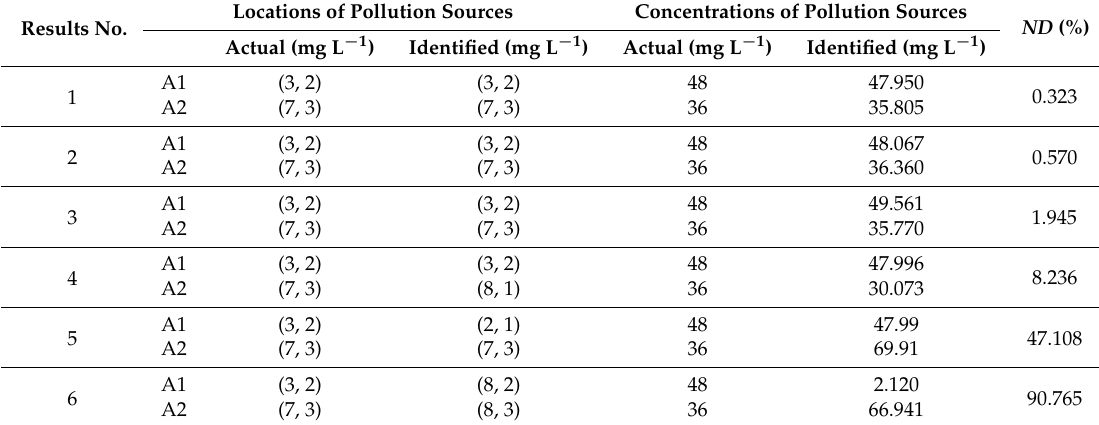
Table 6. Comparison of actual and identified pollution sources characteristics for generation = 10.